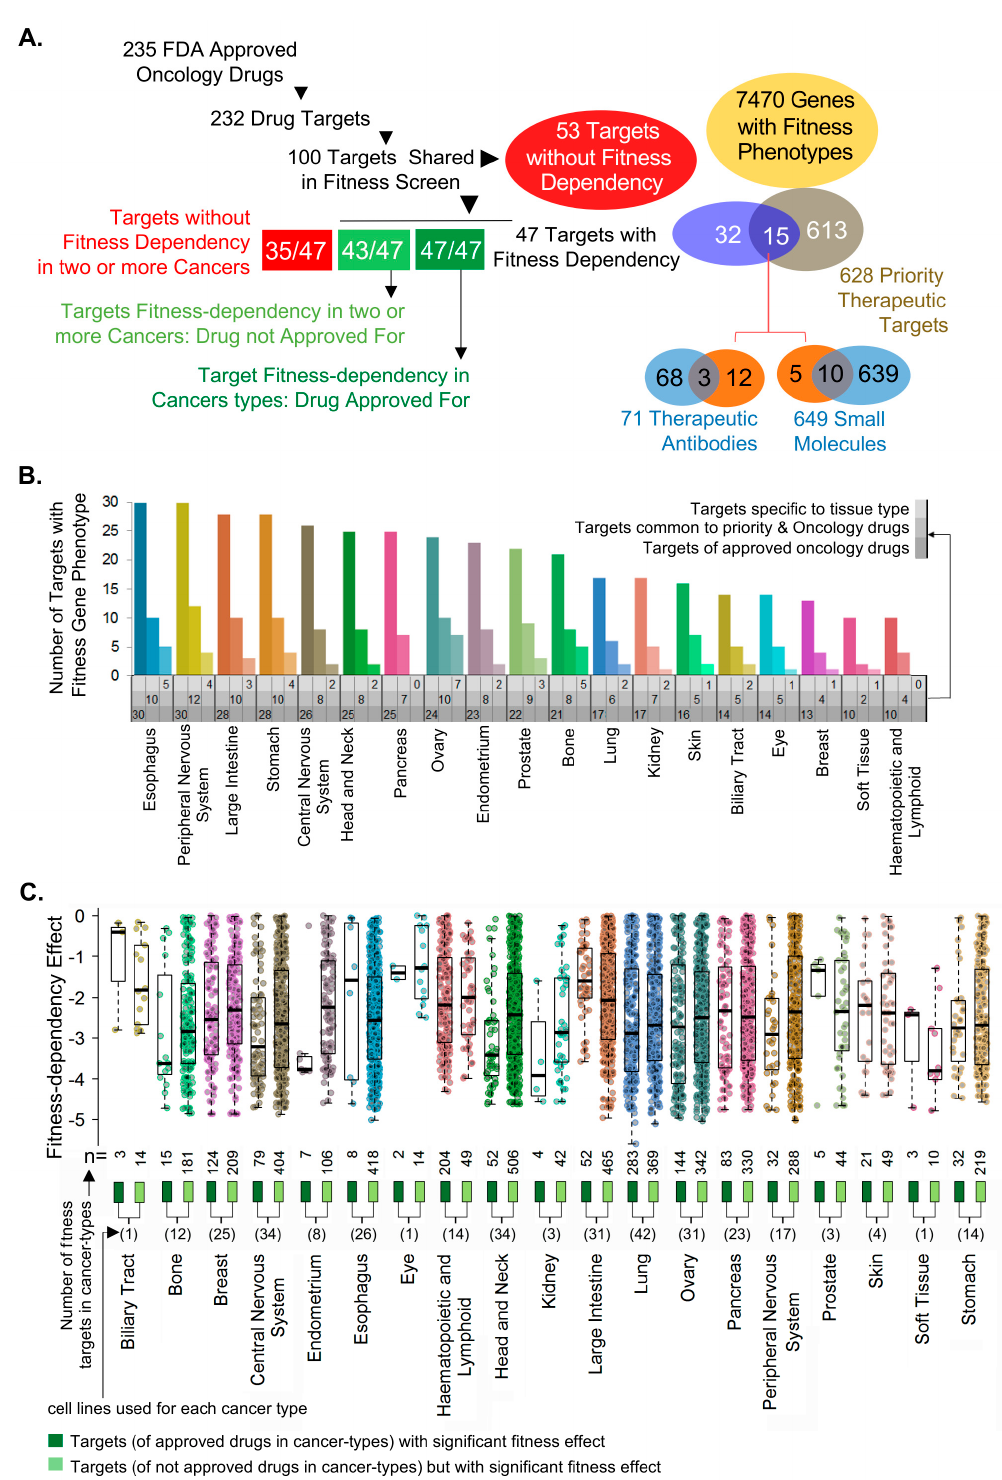
Figure 1. Oncology drug targets and/or effectors as good or poor cellular fitness genes. ( A ) Strategy to examine the fitness- dependency of cancer types for which oncology drugs targeting these targets are either approved or not approved. ( B ) Distribution of 43 cancer targets and/or effectors of FDA-approved drugs, a subset of 14 targets shared with 628 priority therapeutic targets and common targets between these two groups across cancer types, for which drugs targeting these cellular targets are not approved. ( C ) Distribution of significant fitness dependency of 47 molecules across 19 cancer types, for which drugs targeting these molecules are either approved (dark green boxes) or not approved (light green boxes). Here, n—collective number of target fitness values among cancer cell lines in a given cancer type; one dot per target per cell